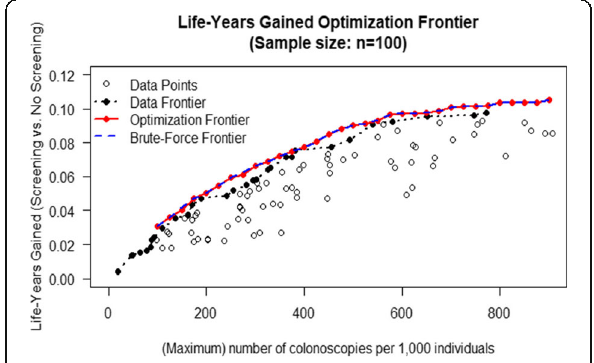
Fig. 1 (abstract O18). See text for